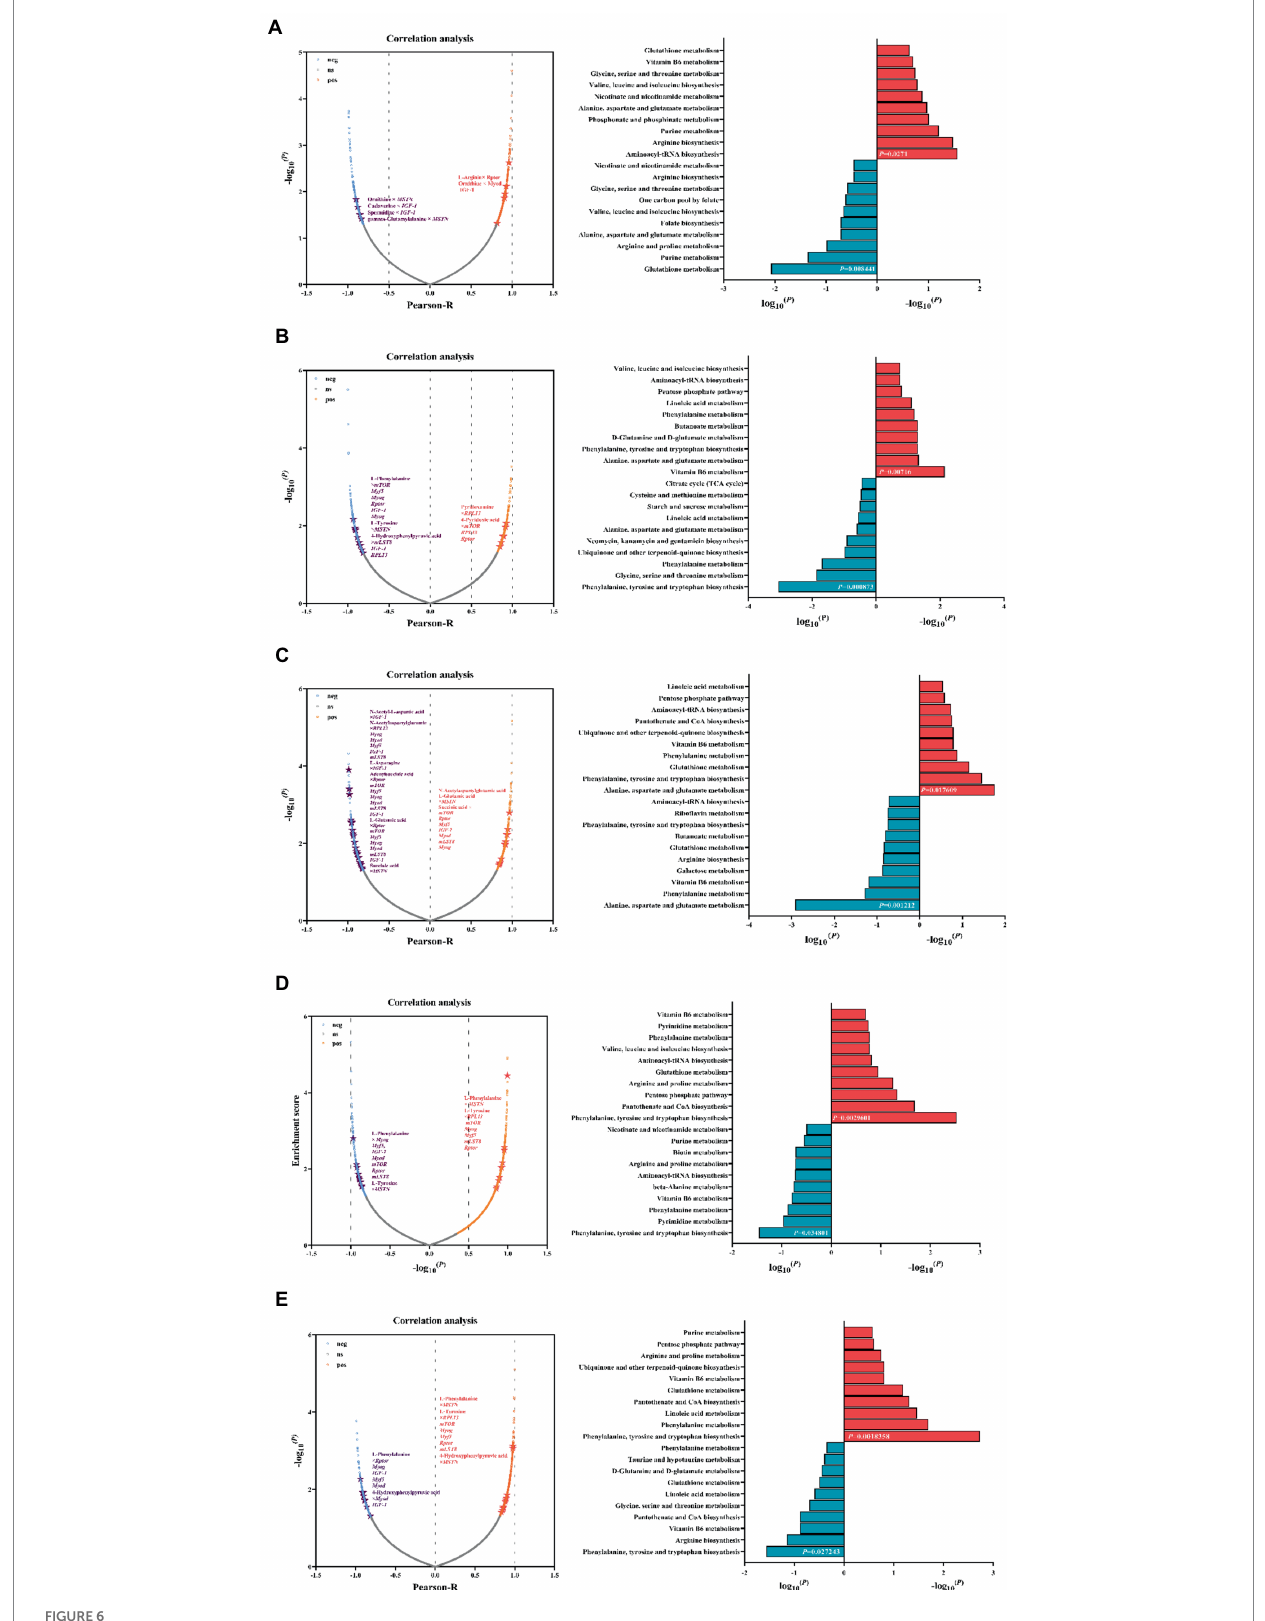
FIGURE 6 Volcano plot of the Pearson correlation between gene expression level associated with muscle proliferation and muscle metabolome of SBM vs. FM (A) , PM vs. FM (B) , CM vs. FM (C) , SEM vs. FM (D) , and CGM vs. FM (E) . A significant negative correlation is labeled with the blue circle ( p < 0.05 and Pearson-R< − 0.8), and a positive correlation is labeled with the orange circle ( p < 0.05 and Pearson-R>0.8; n = 3 biologically independent yellow catfish). Each negatively associated metabolite and gene in the pathway ( p < 0.05) is labeled by the purple star, and each positively associated metabolite and gene in the pathway ( p < 0.05) is labeled by the red star. The bidirectional bar graph exhibits the top 10 enriched KEGG pathways of metabolites that are negatively and positively correlated with gene expression levels associated with muscle proliferation,